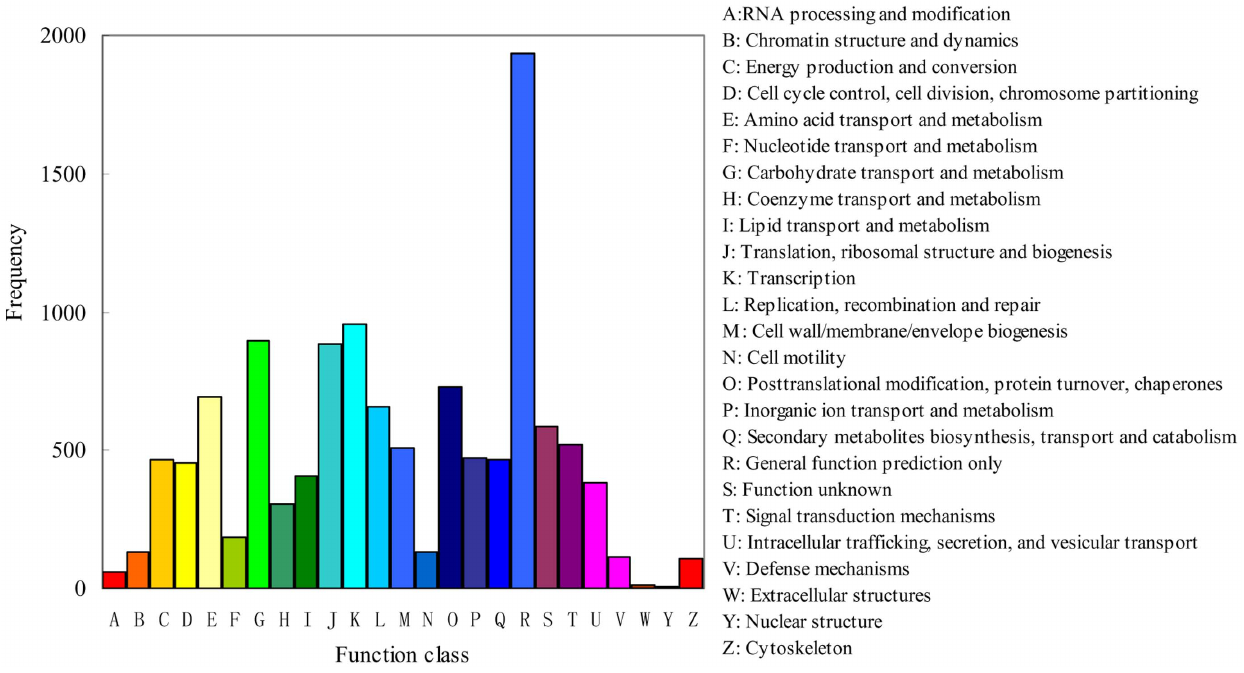
Figure 4. Histogram of the clusters of orthologous groups (COG) classification. Out of 19,317 nr hits, 6,140 unigenes have a COG classification among the 25